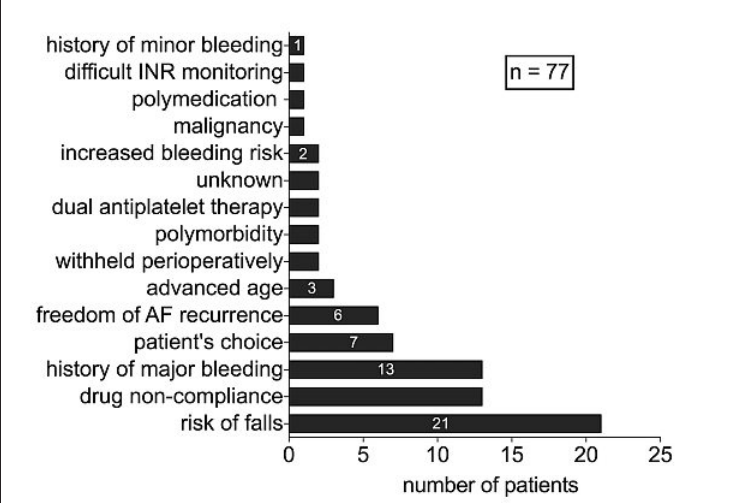
Reasons for withholding oral anticoagulant treatment in high risk patients with a CHADS 2 score